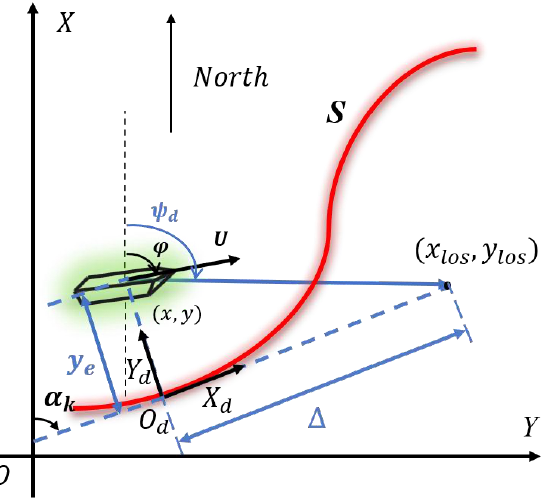
− 𝑥 𝑦 Figure 3. LOS guidance law. 𝑜 − 𝑥𝑦 is the global coordinate system. 𝑜 is the carrier coor- Figure 3. LOS guidance law. o − xy is the global coordinate system. o d − x d y d is the carrier coordinate d d d dinate system. 𝜓 is the desired heading angle. 𝜑 is the angle between the bow of the USV and the system. ψ d is the desired heading angle. ϕ is the angle between the bow of the USV and the vertical axis d vertical axis of the global coordinate system. 𝑦 is the lateral error about path tracking. 𝛼 is the of the global coordinate system. y e is the lateral error about path tracking. α k is the tangential angle at e k tangential angle at the 𝑜 point on the desired path. 𝑈 is the actual velocity of the USV. ∆ is the the o d point on the desired path. U is the actual velocity of the USV. ∆ is the lookahead distance, usually d lookahead distance, usually set as an integer multiple of the ship ’s length. In this paper, we take the set as an integer multiple of the ship’s length. In this paper, we take the multiple as